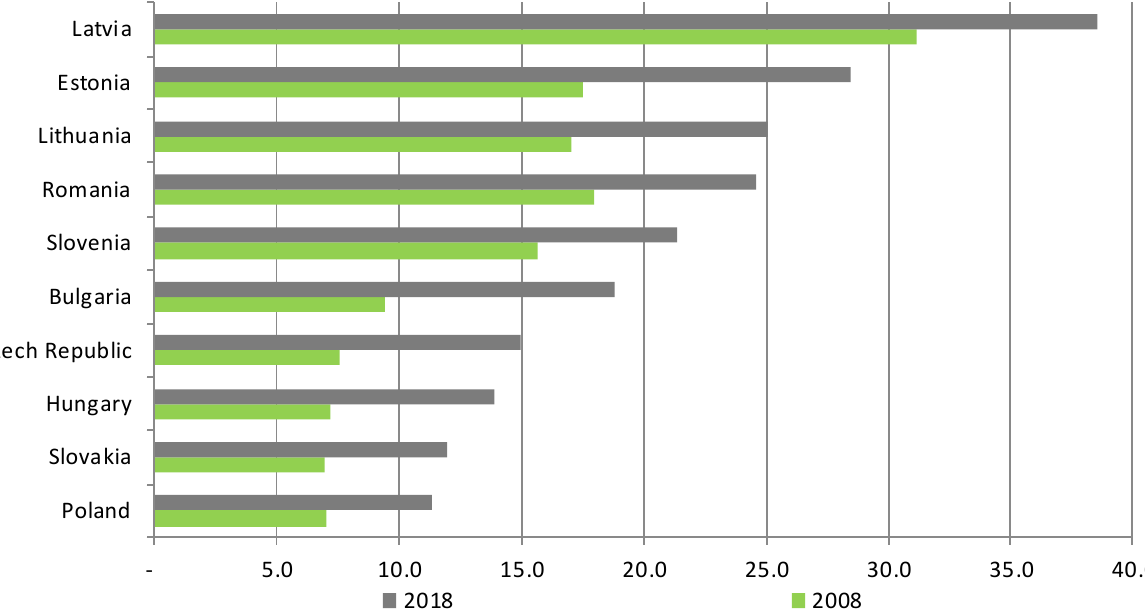
Figure 6. The share of RES in energy consumption in CEE countries in 2008 and 2018 as percentages.